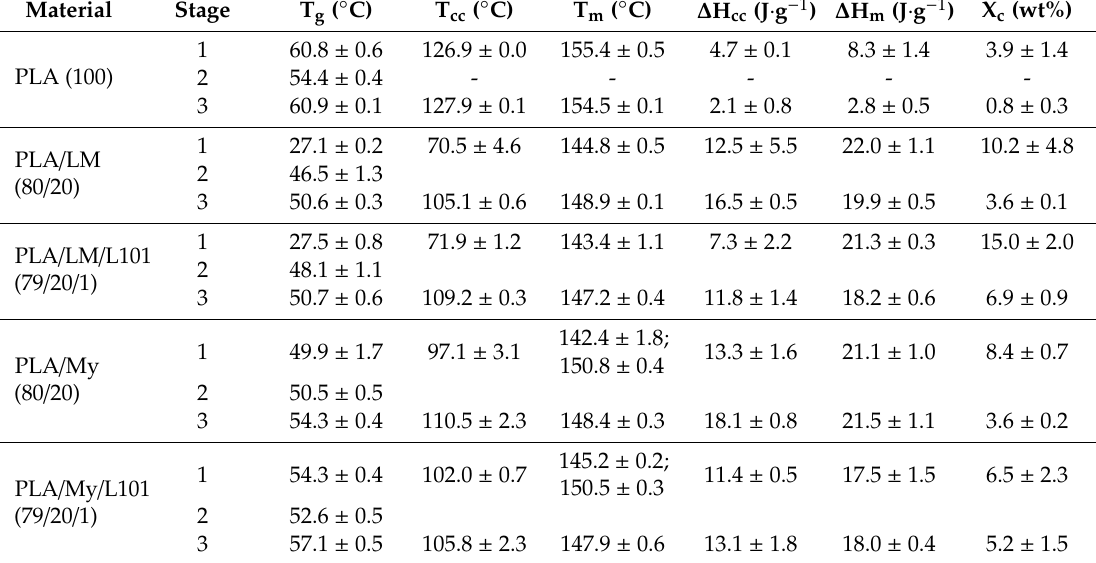
Figure 6. Representative differential scanning calorimetry (DSC) thermograms of polylactide (PLA)-based materials corresponding to the heating stages ( a ) and the cooling stage ( b ). Table 2. Differential scanning calorimetry (DSC) parameters of polylactide (PLA)-based materials, stage n°1 indicated the first heating, stage n°2 indicated the cooling, and stage n°3 indicated the second heating.